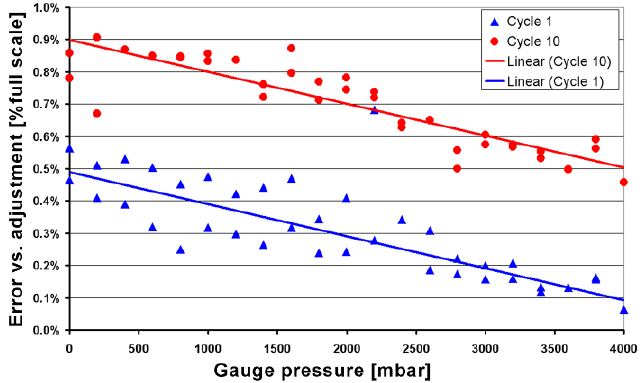
Figure 15. Relative error of pressure sensor voltage output compared to a linear regression vs. gauge pressure for cycles 1 and